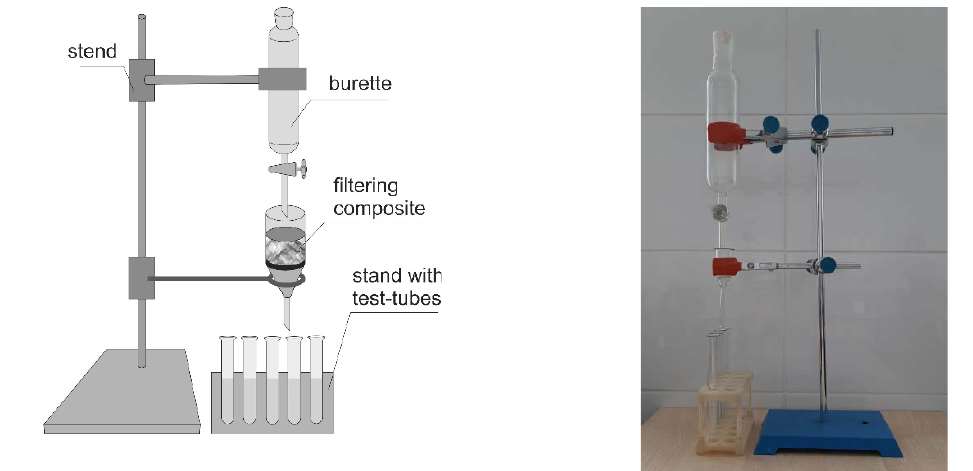
Figure 1. Installation for the study of the process of the dynamic sorption of lead ions.